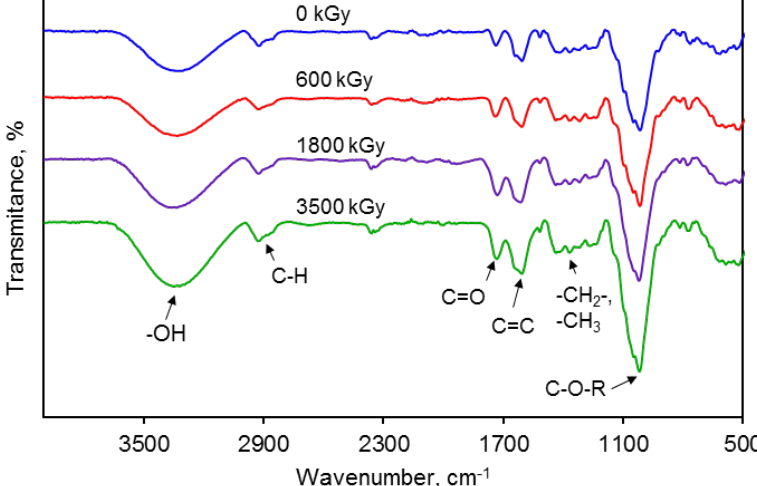
Figure 4. FTIR spectrum of the irradiated orange peel sample at different